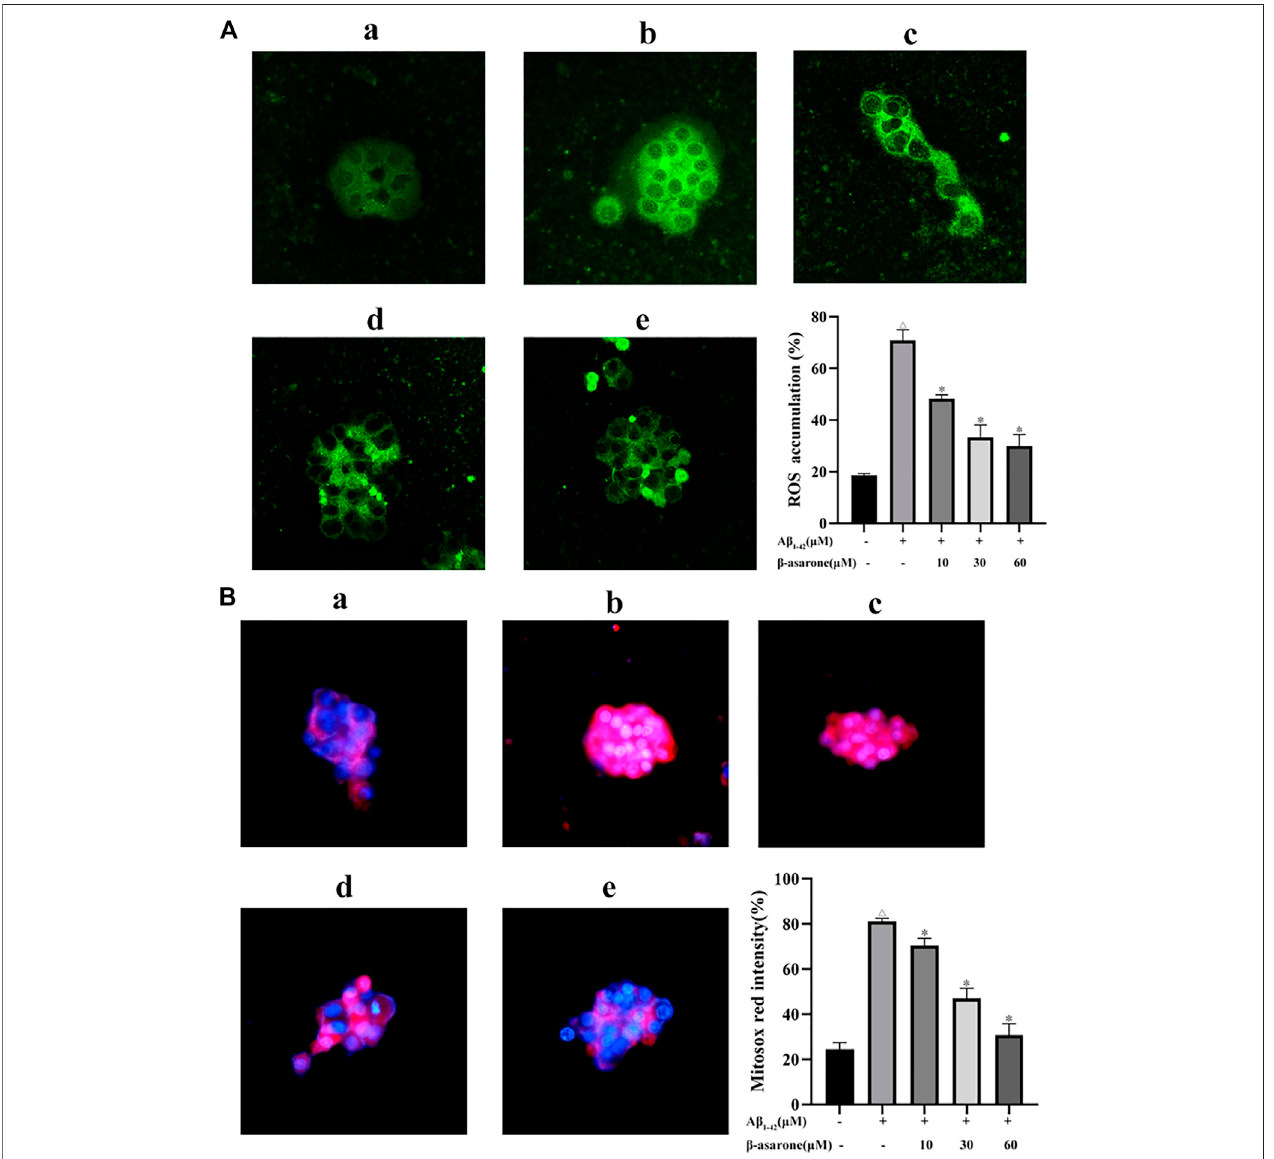
FIGURE 5 | Effect of β -asarone on A β 1 – 42 -induced ROS production. After PC12 cells were treated, the intracellular ROS level was observed using a fl uorescence microscope( × 400)anddetectedusinga fl uorescencemicroplatereader (A) . (B) ThemitochondrialROSgenerationwasobservedusingMitoSOXspeci fi creddye(redcolor).a, Control group; b, A β 1 – 42 -alone treatment group; c, A β 1 – 42 + β -asarone (10 μ M) group; d, A β 1 – 42 + β -asarone (30 μ M) group; e, A β 1 – 42 + β -asarone (60 μ M) group. △ p < 0.05 compared with the control group; * p < 0.05 compared with the A β 1 – 42 -alone treatment group. Data from three independent experiments were expressed as mean ±